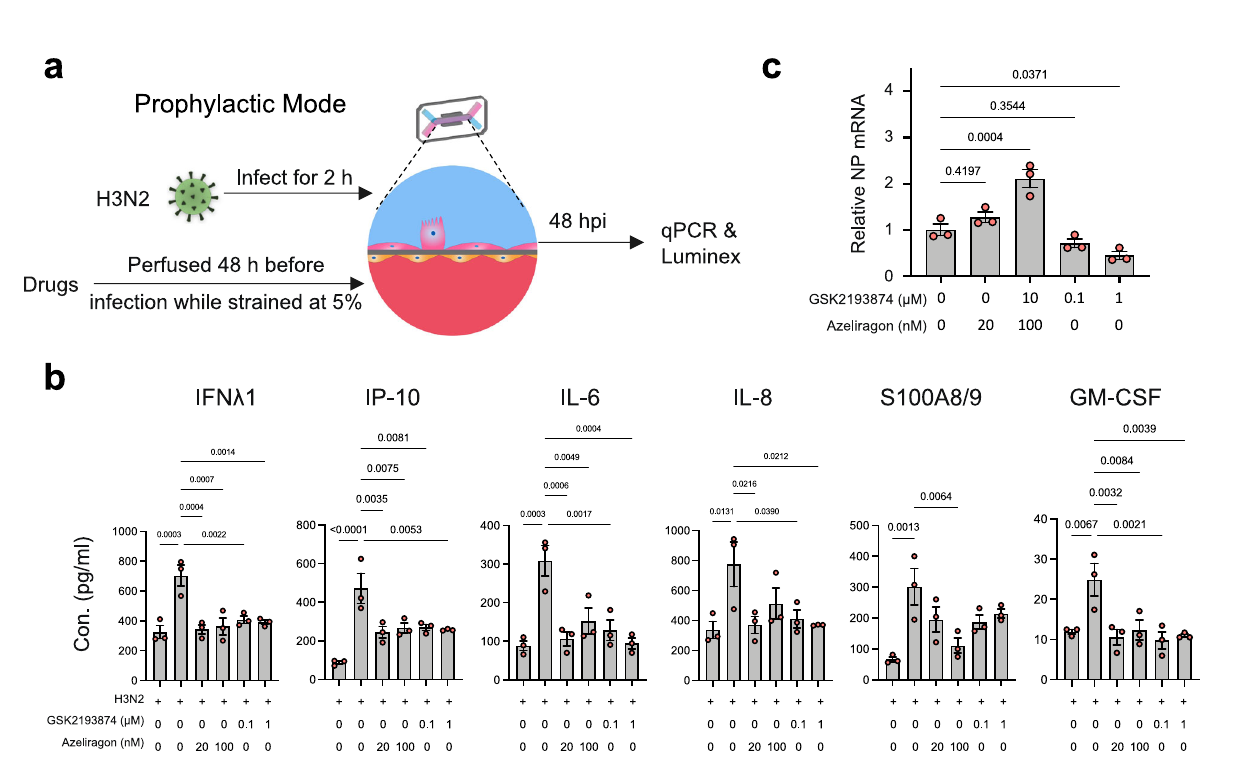
Fig. 7 RAGE mediates mechanical strain-induced activation of innate immunity during infection. a Illustration of the experimental protocol involving prophylactic treatment with signaling inhibitors for 48 h prior to viral infection of the human alveolus chip. b Graphs showing cytokine levels on chips. c Graph showing mRNA levels of H3N2 NP in epithelial cells treated with azeliragon or GSK2193874 at indicated doses on-chip. Data in b , c represent mean ± SEM; n = 3 biological chip replicates; one-way ANOVA with Dunnett ’ s multiple comparisons correction. Source data are provided as a Source Data fi